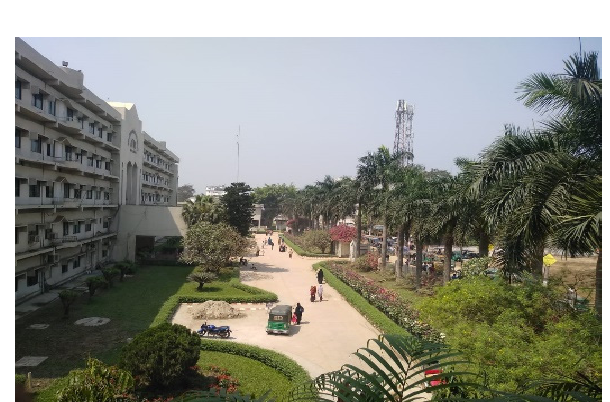
Soc. Sci. 2022 , 11 , x FOR PEER REVIEW